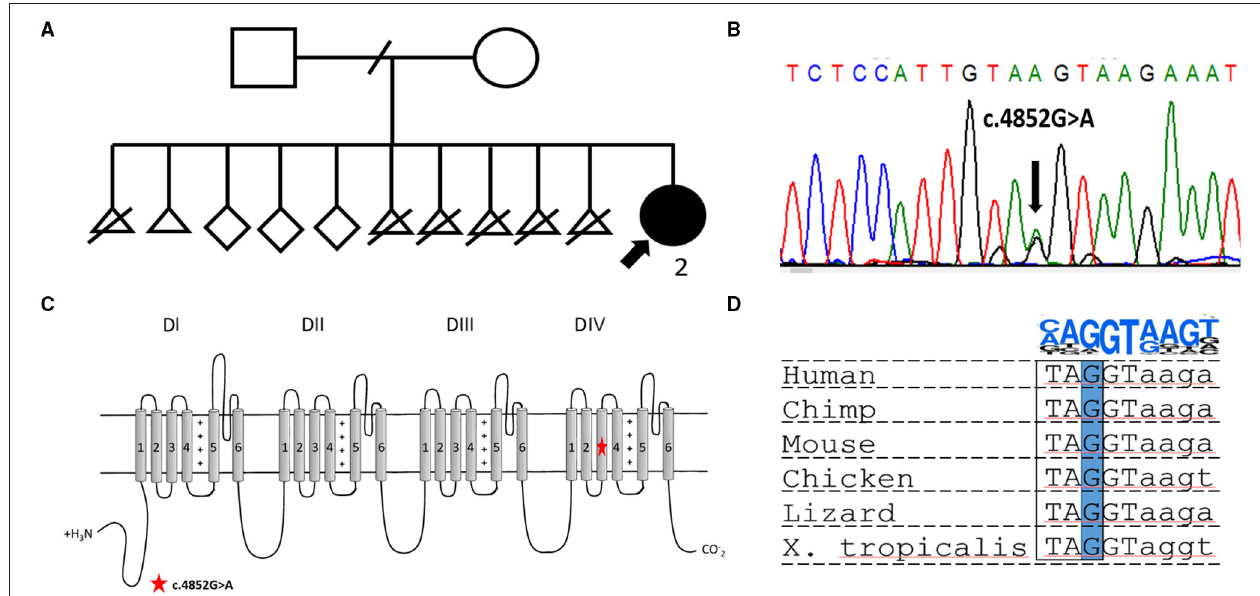
FIGURE 1 | (A) Pedigree of the reported family. The proband is indicated by a bold arrow. (B) Electropherogram showing the heterozygous variant NM_001165963.2:c.4852G > A [p.(Gly1618Ser)] confirmed in the proband by Sanger sequencing. (C) Scheme of Nav1.1 channel structure. The location of the novel missense variant is indicated by a red star. (D) Multiply alignment showing the conservation of the affected nucleotide in different vertebrates. On the top is a position weight matrix of the site of the splicing donor.